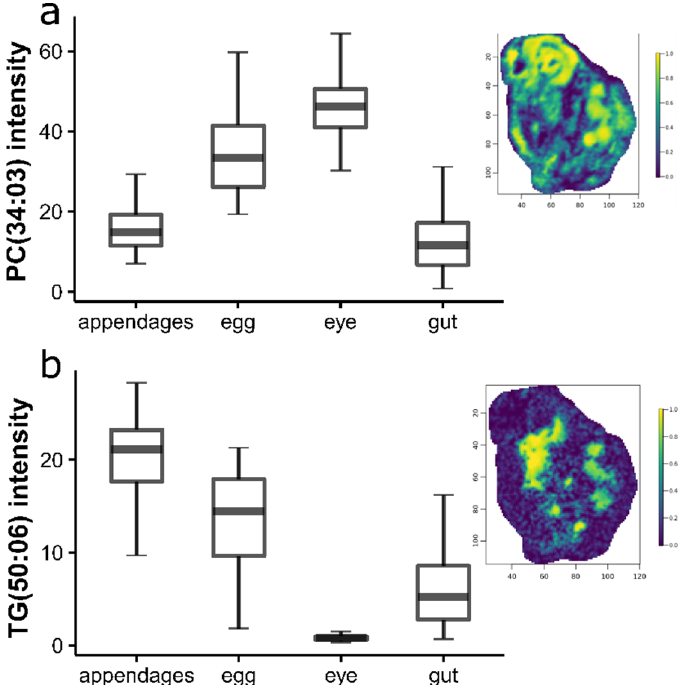
Figure 4. Boxplots showing the differences in the abundance of a representative phosphatidylcholine and triacylglyceride; ( a ) PC(34:03) at m/z = 778.5347, and ( b ) TG(50:06) at m/z 861.6503, between Daphnia magna appendages (blue), eggs (yellow), eye (green), and gut (red) following DESI-MS analysis. The error bars represent a 95% confidence interval. The representative ion images are overlaid on each plot to visualize the distribution of each lipid across the whole animal. The colour scale indicates the relative abundance of each lipid.